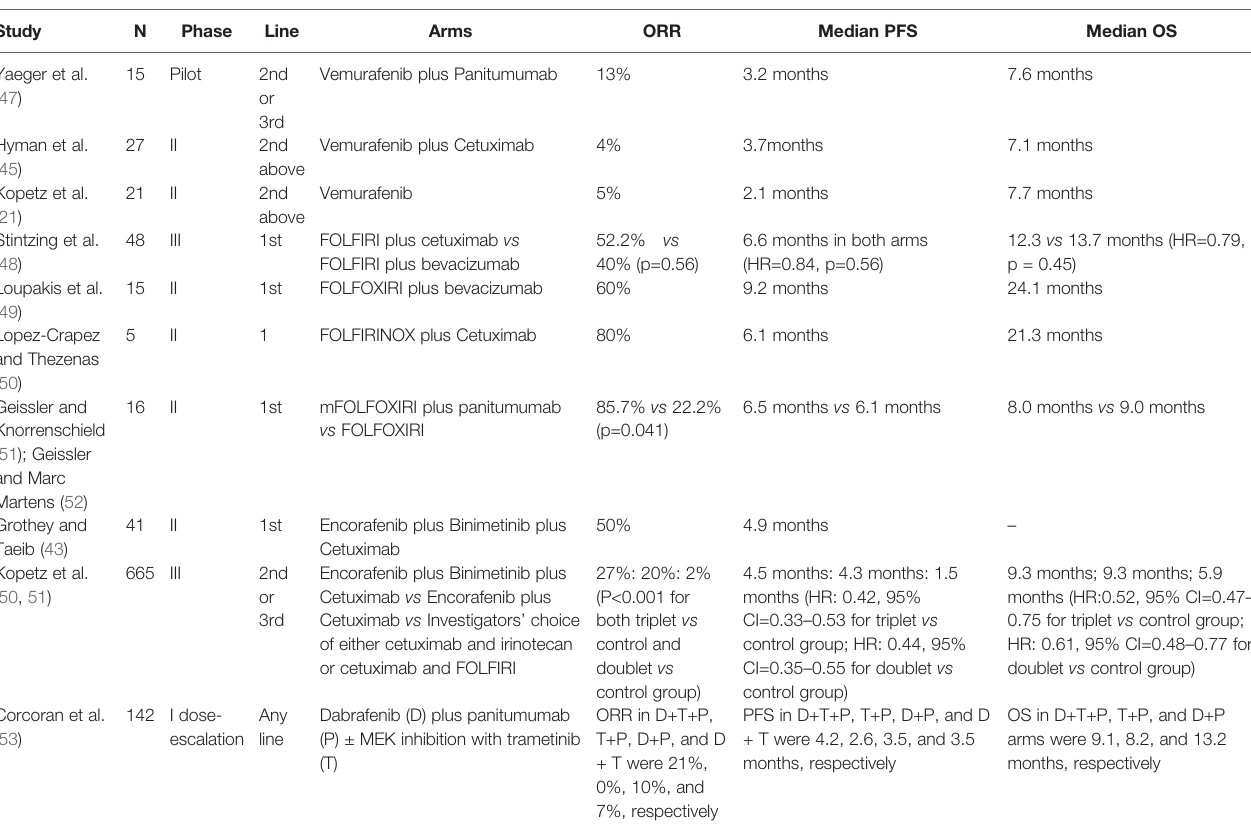
TABLE 5 | Trials evaluating role of targeted therapy in BRAF mutated patients. Study